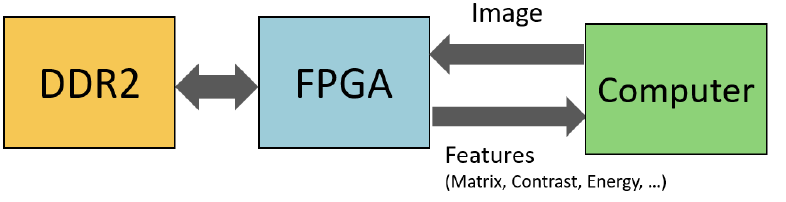
Figure 13. Validation platform architecture.